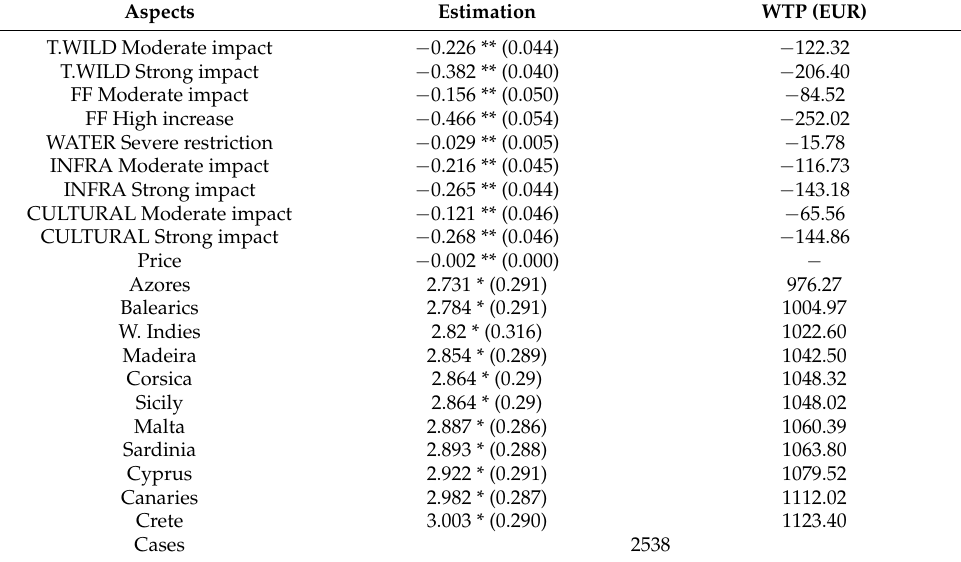
Table 4. Asc-logistic and WTP estimation